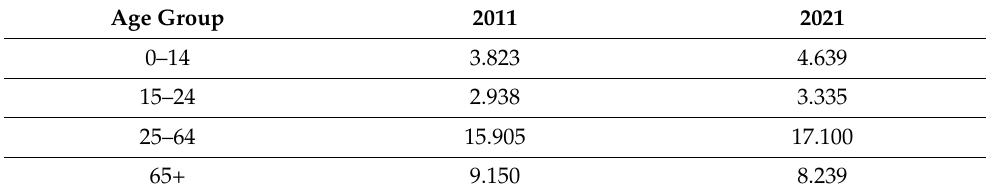
Table 1. Number of individuals per age group in the Alvalade Civil Parish, in 2011 and